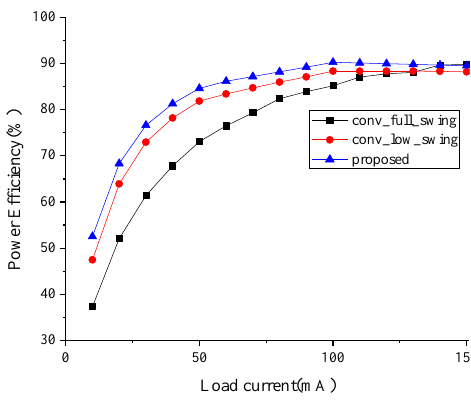
Figure 10. Measured gate driving loss of buck converters.